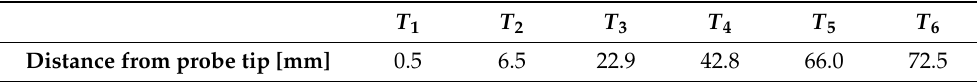
Table 2. Distances from the probe tip to the temperature measurement